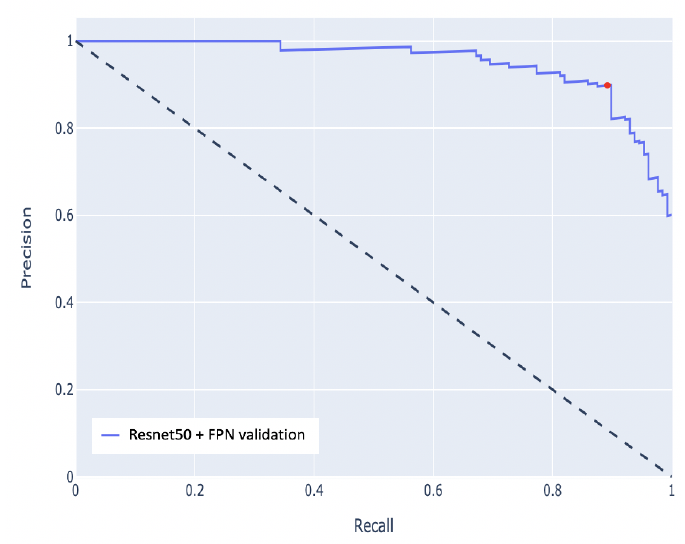
Figure 5. Precision and recall curve for validation split. Table 3. Evaluation results in the test dataset. The threshold (0.44) is used to compute all metrics except AP and ECE, which do not depend on the threshold